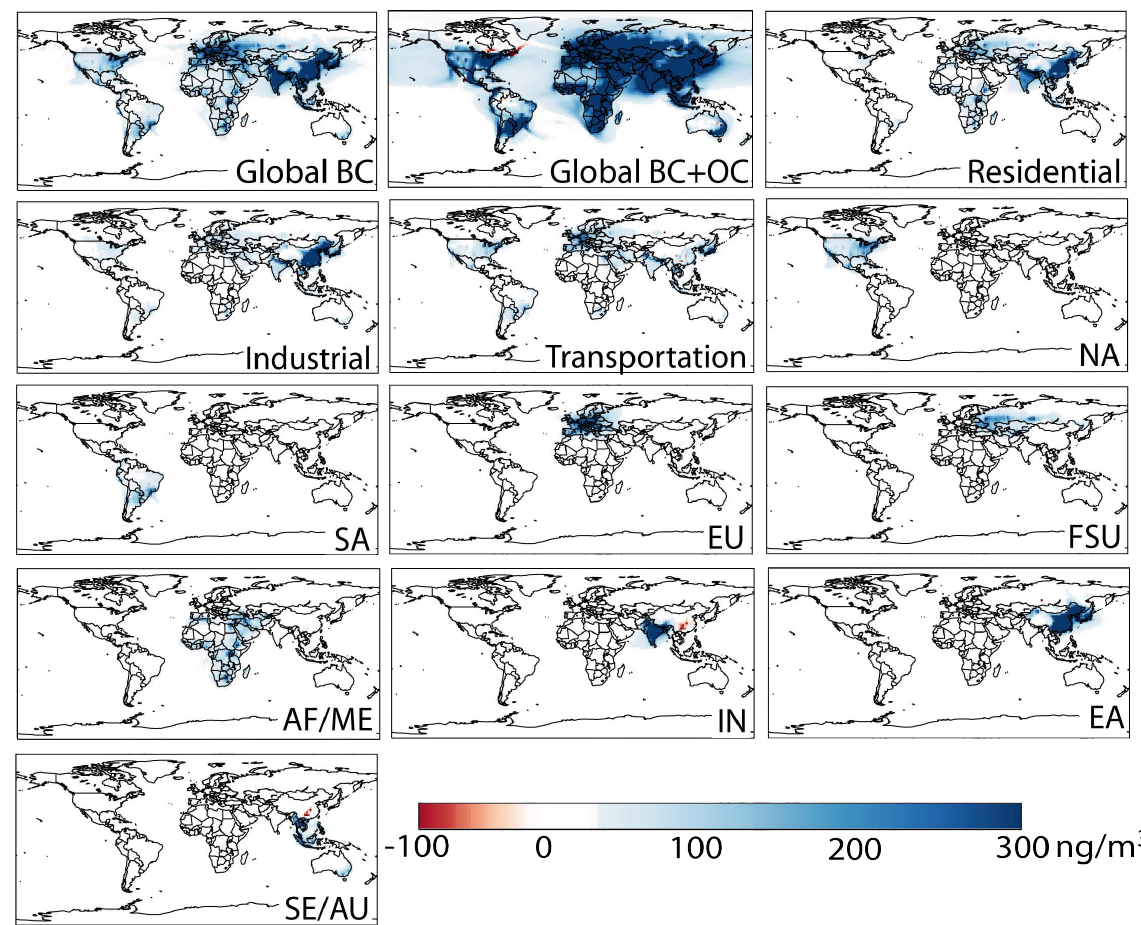
Fig. 4. Reduction in annual average surface PM 2 . 5 concentration (ngm − 3 ) for the global, sectoral, and regional emission reductions relative to the base